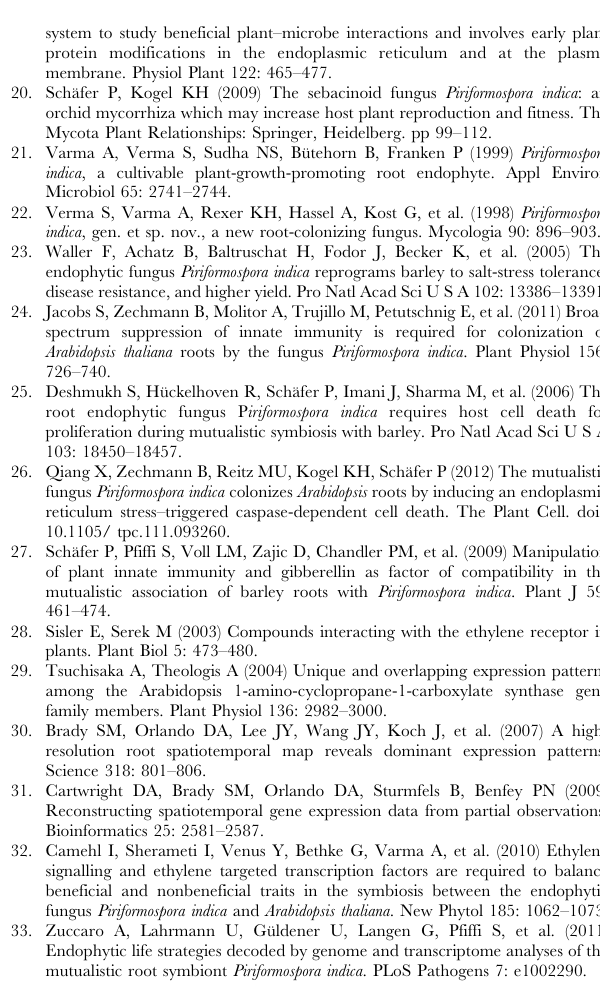
dopsis roots according to the AREX